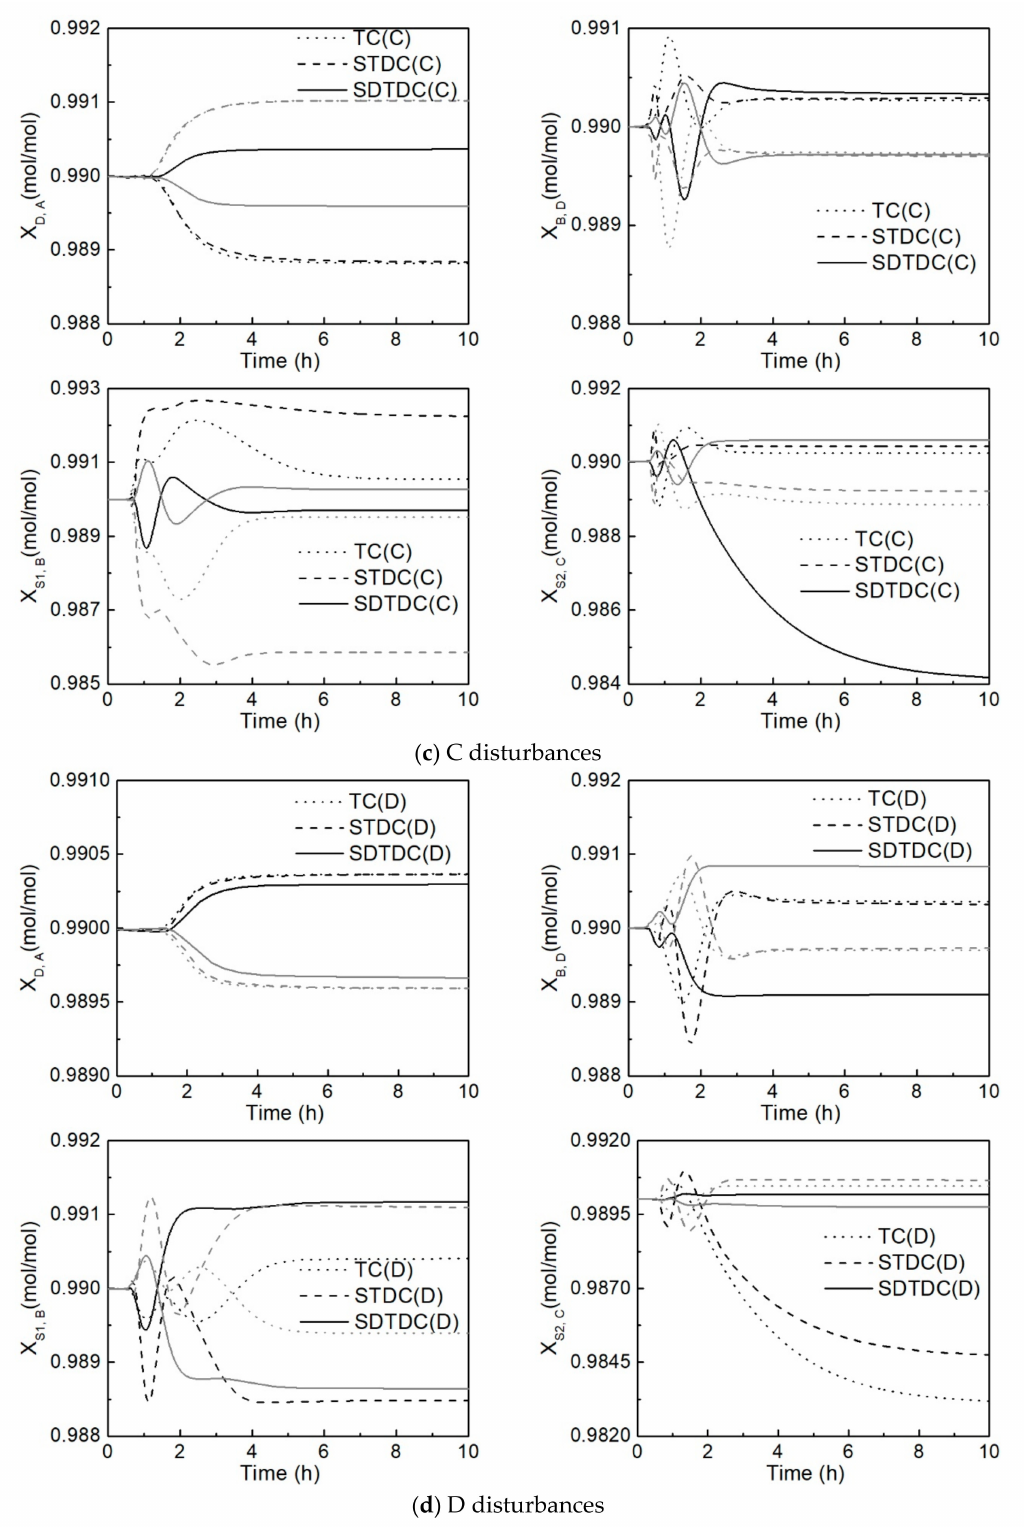
Figure 10. Dynamic responses in face of ± 10% feed composition